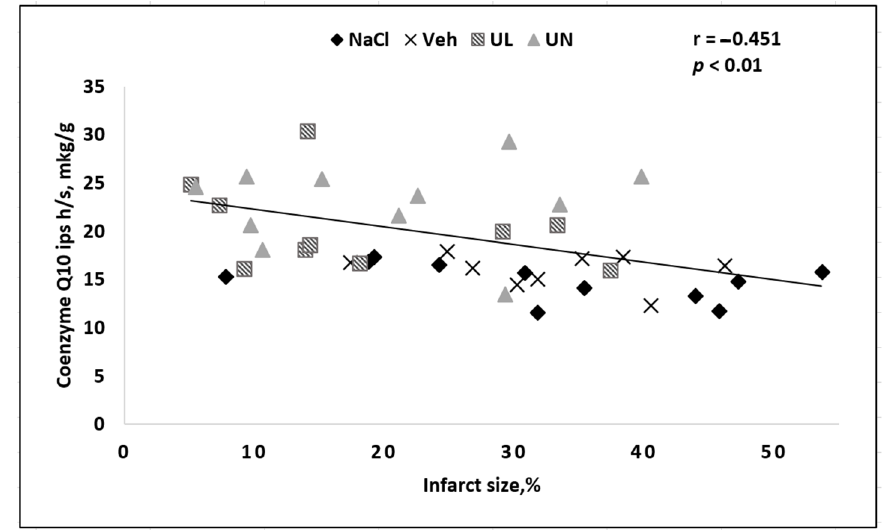
Figure 10. Correlation between the brain infarct size and CoQ10 brain level in the ipsilateral hemisphere in rats after occlusion of the middle cerebral artery. Groups: NaCl–MCAO+NaCL; Veh–MCAO+Vehicle; UL–MCAO+Ubiquinol; UN–MCAO+Ubiquinone.